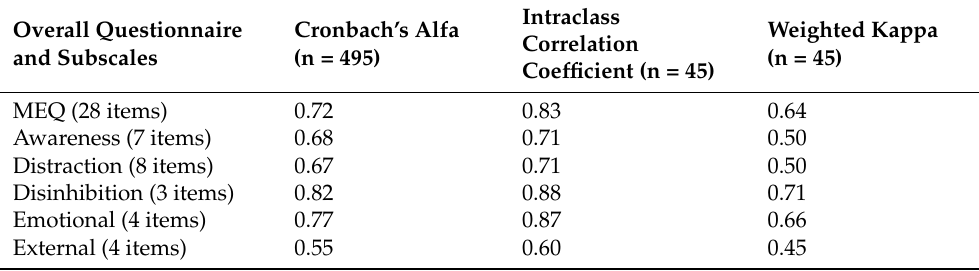
Table 2. Cronbach’s alfa (n = 495), intraclass correlation coefficient and weighted kappa for the test-retest procedure (n = 45) in Romanian validation of MEQ.